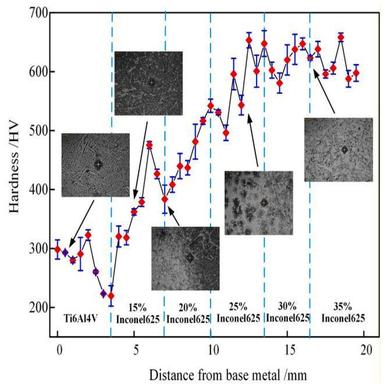
spatial distribution of the Vickers hardness values.